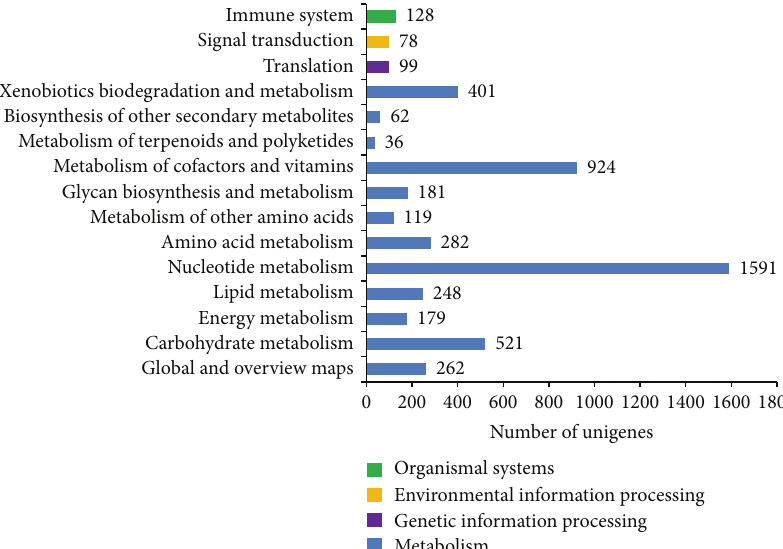
Figure 7: Kyoto Encyclopedia of Genes and Genomes (KEGG) pathway assignment for assembled unigenes from V. mandarinia . The unigenes have been categorized to metabolism, genetic information processing, environmental information processing, and organismal systems pathways.